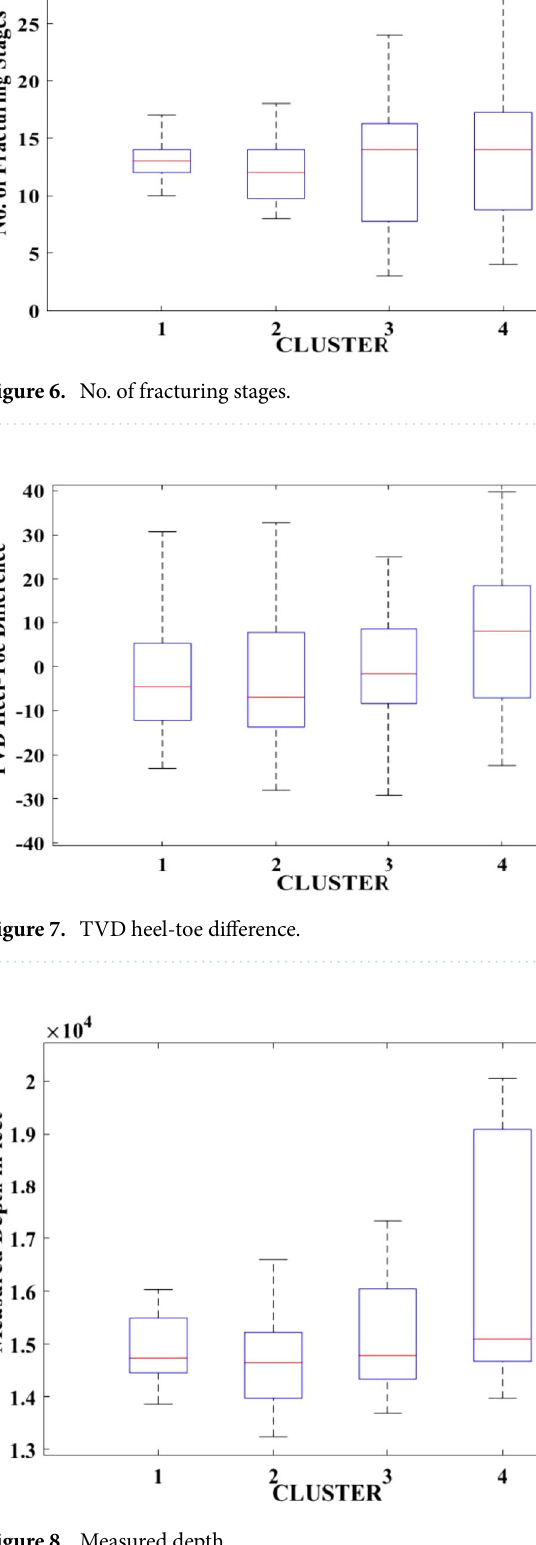
Figure 8. Measured